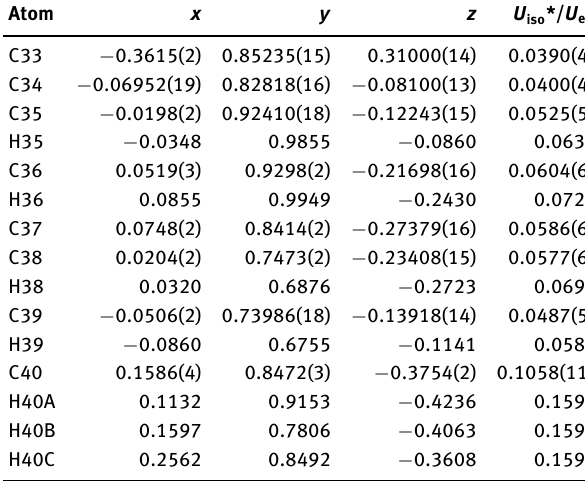
Table 2: Fractional atomic coordinates and isotropic or equivalent isotropic displacement parameters (Å 2